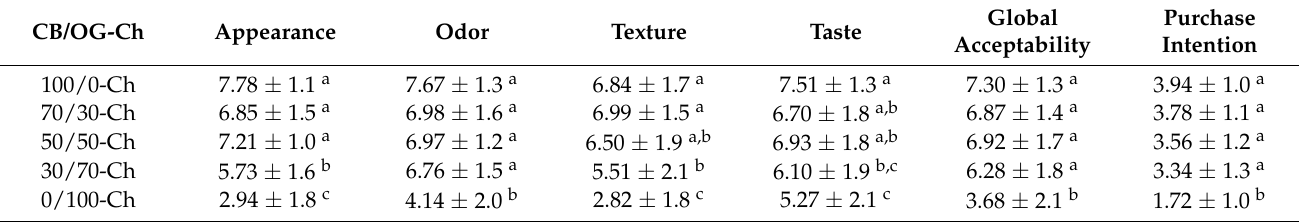
Table 9. Scores rated by the untrained panel on the sensory attributes, overall acceptability and purchase intention of the CB/OG-based chocolates (CB/OG-Ch) formulated with the different CB/OG blends.